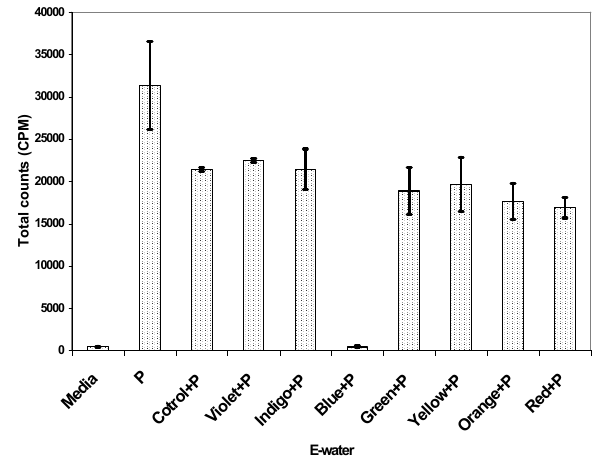
Figure 6: The proliferative responsiveness of peripheral blood T cells with different irradiated waters to phytoheamagglutinin (P). Cells were incubated with media, media + P and with media + P + E water passed through 0.22 N filter. The experiments were done thrice in triplicates and are represented as Mean ± SD. Third, the impact of the irradiated water on the growth of mosquito larvae was assessed. Data shown in Table 2 are observations from t=24 hrs, 48hrs, 72 hrs, 96 hrs. The experiment was carried out for 10 days (240 hrs), however, no difference was noted between 96 and 240 hrs (data not shown). These studies indicate that E- violet and E-indigo showed similar values to